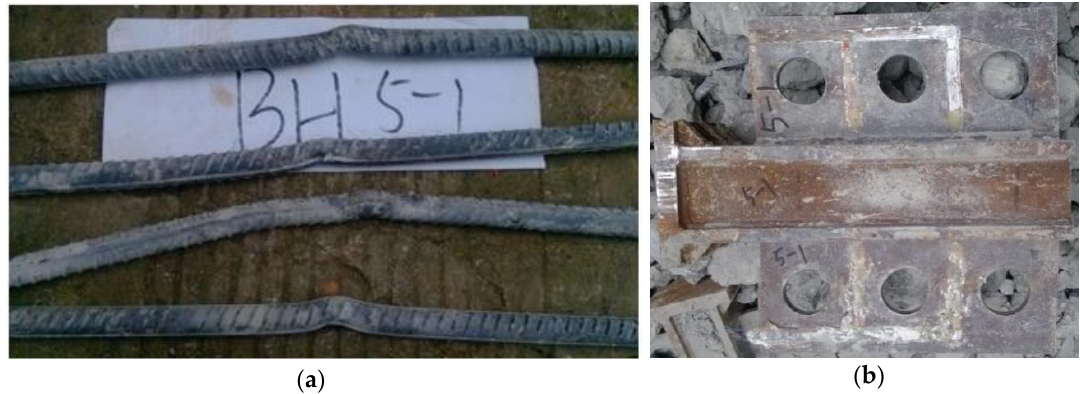
Figure 14. Rib plate and reinforcement of the BH 5-1 specimen after the test: ( a ) Deformation form of reinforcement; ( b ) Deformation form of rib plate.